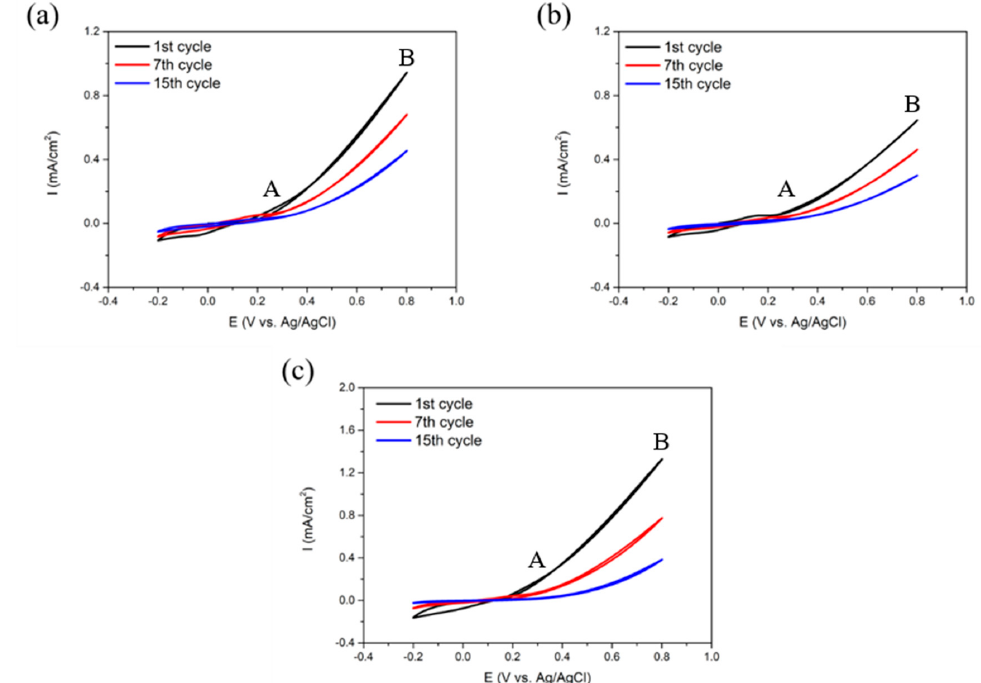
Figure 2. Cyclic voltammograms of SPAN deposited on an ITO electrode using electropolymerization with AN/DABSA mole ratio of ( a ) 10 (pH = 6.24), ( b ) 8.8 (pH = 6.12), and ( c ) 3.4 (pH = 5.86) at a scan rate of 25 mV/s.